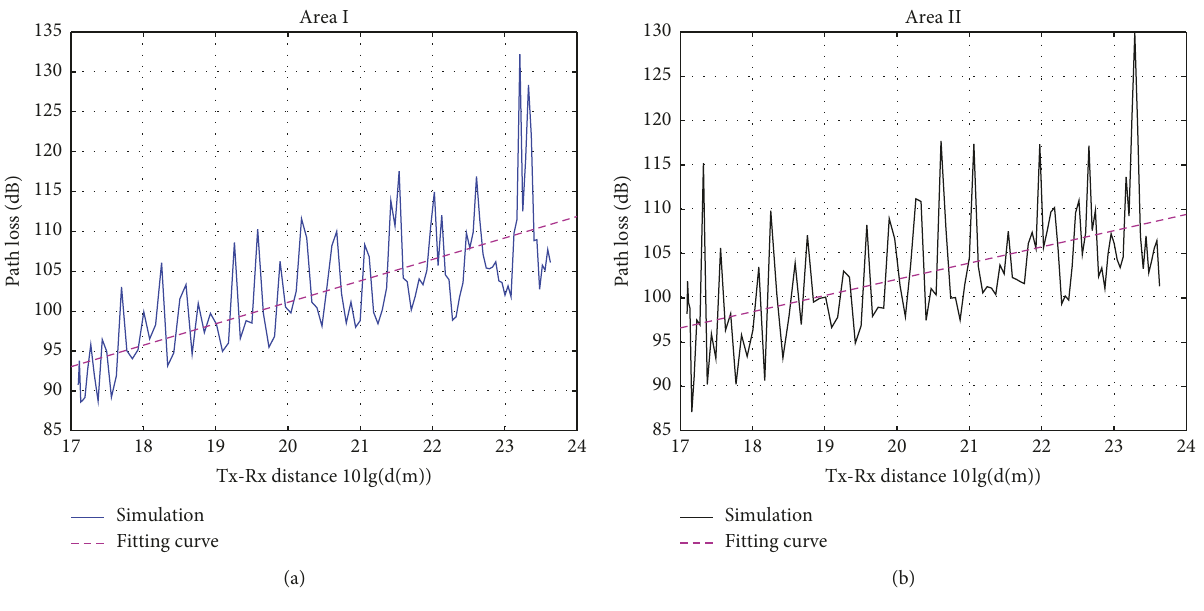
Figure 4: Simulation and fitting results. (a) Area I. (b) Area II. Table 4: Parameter fitted